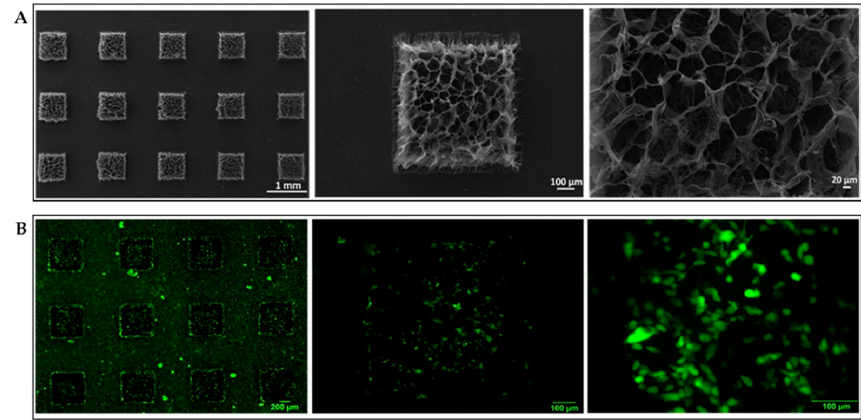
Figure 8. ( A ) Scanning electron microscope images of micropatterned SF/gelatin methacrylate (GelMA) (GelMA) porous scaffolds; ( B ) Fluorescence images (2×, 10×, and 20×) of NIH-3T3 fibroblast cells porous scaffolds; ( B ) Fluorescence images (2 × , 10 × , and 20 × ) of NIH-3T3 fibroblast cells stained with live/dead viability kit after cultured on the micropatterning scaffolds for one day. Reproduced Reproduced from [108]. from